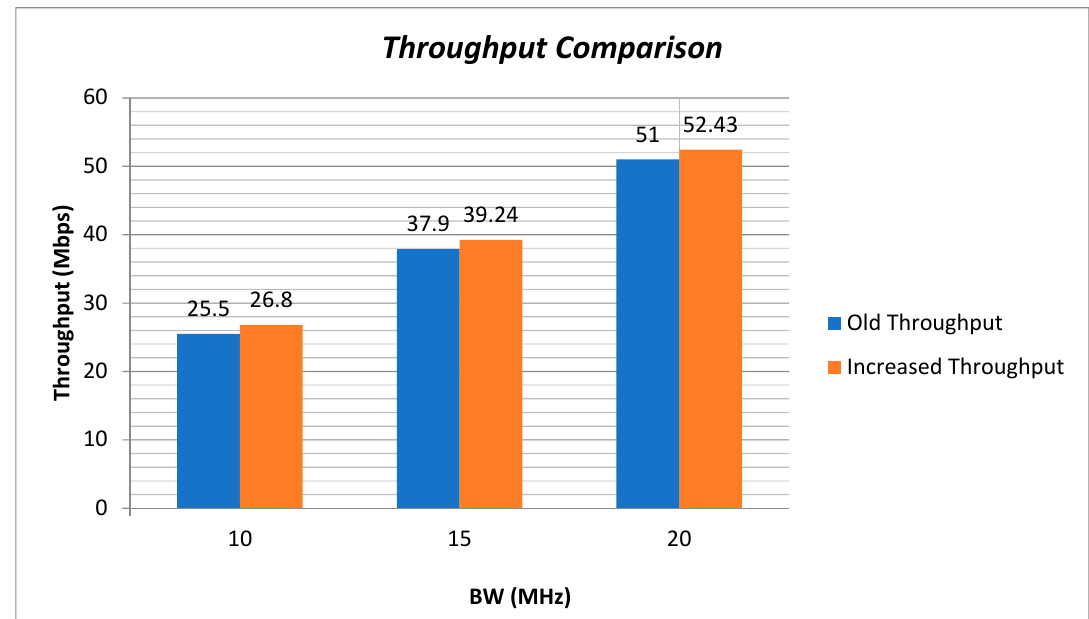
Figure 10. Throughput comparison for 16 QAM (Quadrature Amplitude Modulation).